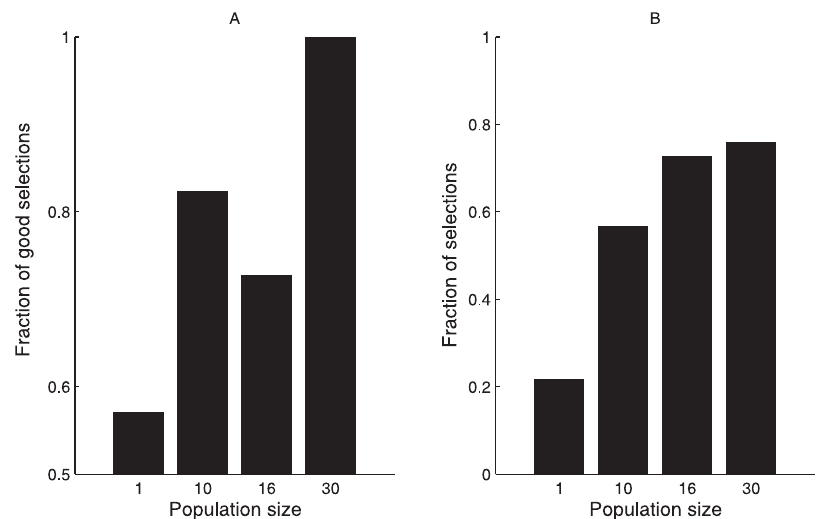
Figure 2. Shelter selection frequency. (A) Fraction of replicates ending with good selection (i.e. selection of the darkest shelter) according to population size (=discrimination efficiency); (B) Fraction of replicates ending with the selection of one of the two shelters according to population size (=ability to make a choice) (see SI 2 for statistical criteria of selection).